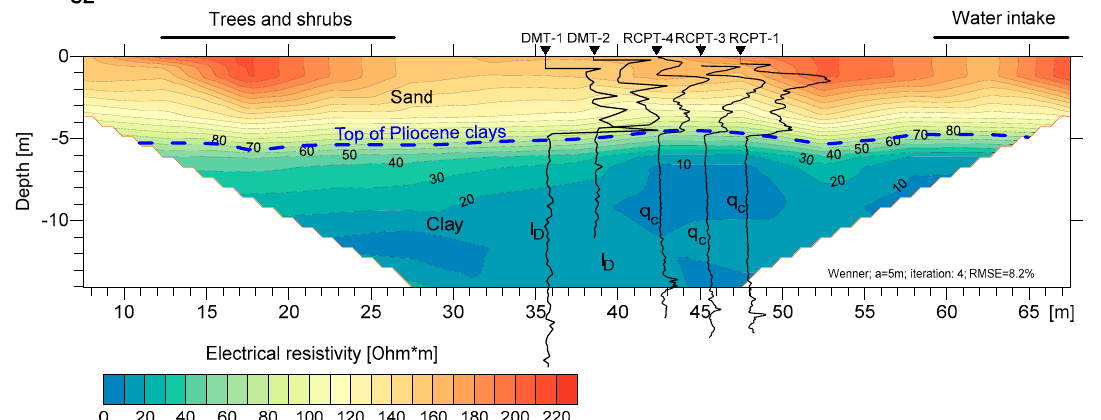
Figure 17. Geoelectrical cross-section of the Stegny site compared with the cone resistance q c from CPTU and material index from DMT tests.